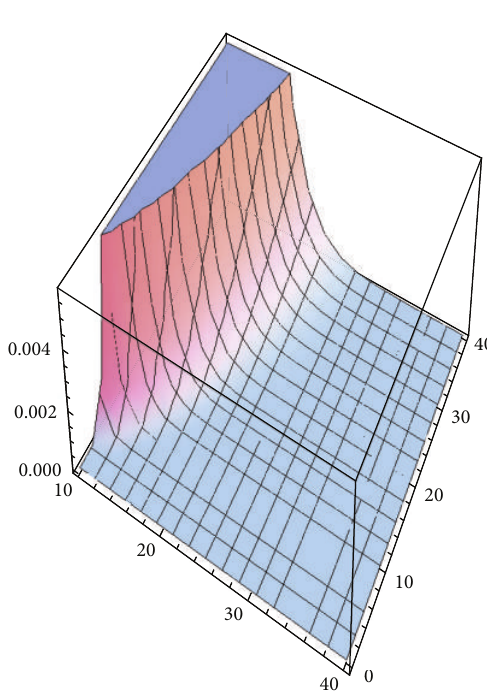
Figure 3: Solution of (41) (piezometric head).